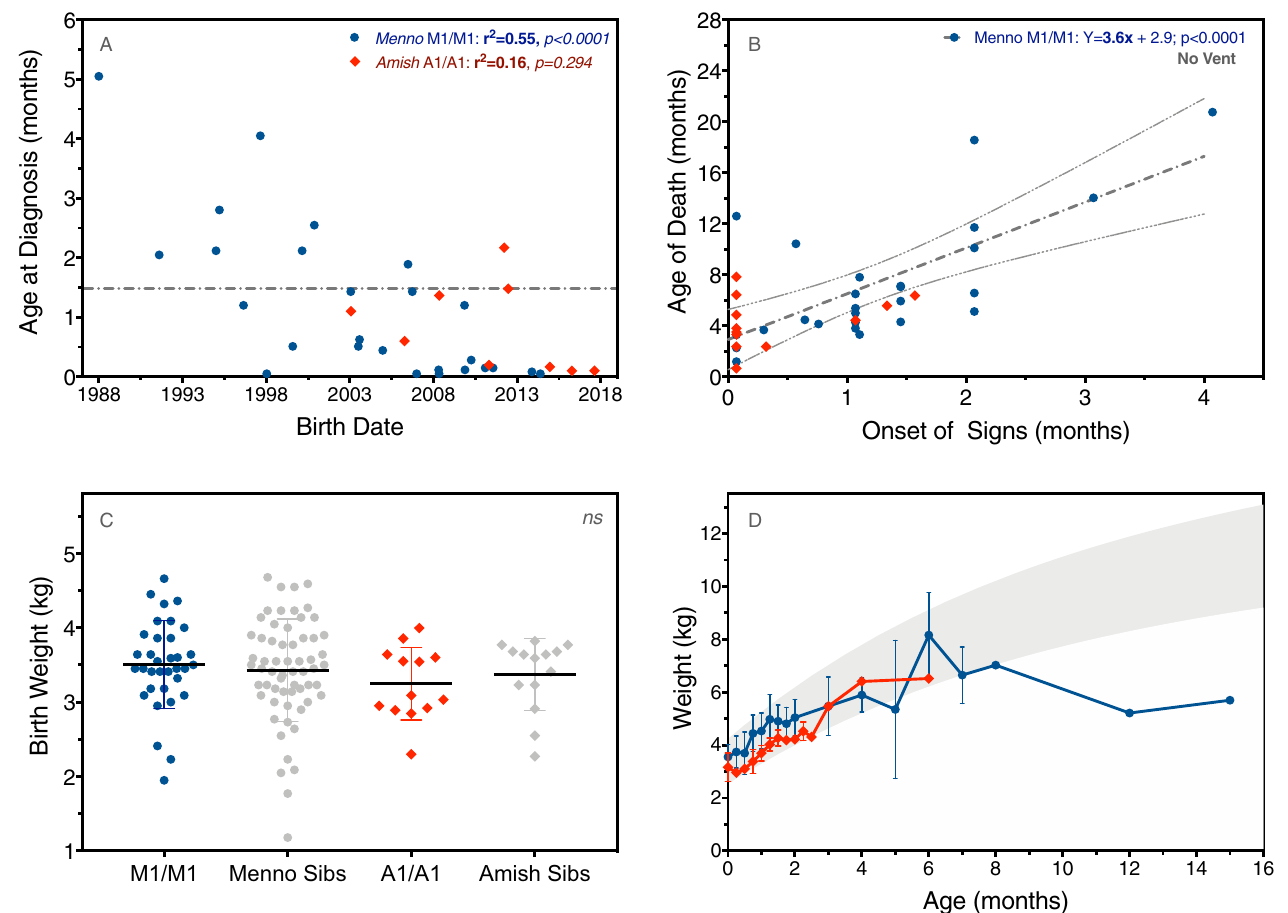
Fig 4. Diagnosis, prognosis, and growth in patients with 2 copies of SMN2 . (A) Age of diagnosis correlated to birth date (i.e. children born more recently were diagnosed earlier; r s = -0.71, p < 0.0001). Among A1/A1 (red diamonds; n = 7) and M1/M1 (blue circles; n = 9) homozygotes born within the last decade, 15 (94%) were diagnosed before 6 weeks of age (gray dashed line). (B) There was a strong linear correlation between clinical onset and age of death among Mennonite but not Amish patients with 2 SMN2 copies (gray dashed line with 95% confidence bands; p < 0.0001). (C) M1/M1 (blue circles) and A1/A1 (red diamonds) homozygotes and their unaffected siblings (gray symbols) had similar birth weights. (D) Amish and Mennonite children with 2 copies of SMN2 remained on the growth curve, without gastrostomy, until about 6 months of age (gray shaded area represents World Health Organization reference data, 5 th to 95 th percentile).